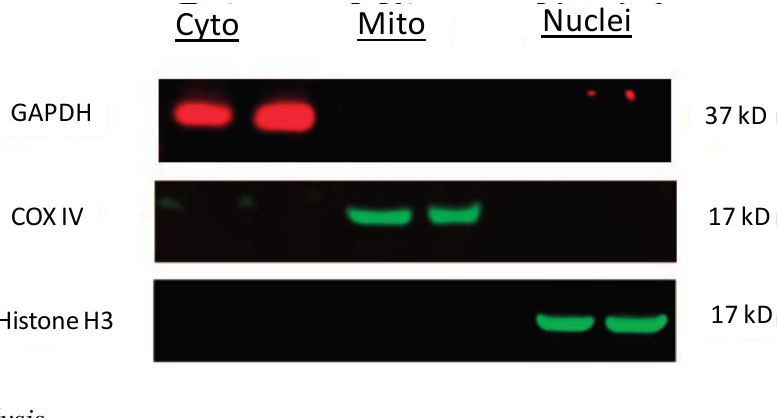
Figure 7. Western blots showing purity of subcellular fractions. Cytosolic, mitochondrial and nuclear fractions were isolated according to the protocol described in the Experimental section and equal amount of proteins (20 µg) were loaded side by side on the same gel. The membrane was probed separately with three primary antibodies against GAPDH, COX IV and Histone H3. A single band for GAPDH at approximately 37 kD in the cytosolic fraction, an obvious band for COX IV at approximately 17 kD in the mitochondrial fraction, and a band for Histone H3 closing to 17 kD in the nuclear fraction was observed. There was no obvious contamination among different